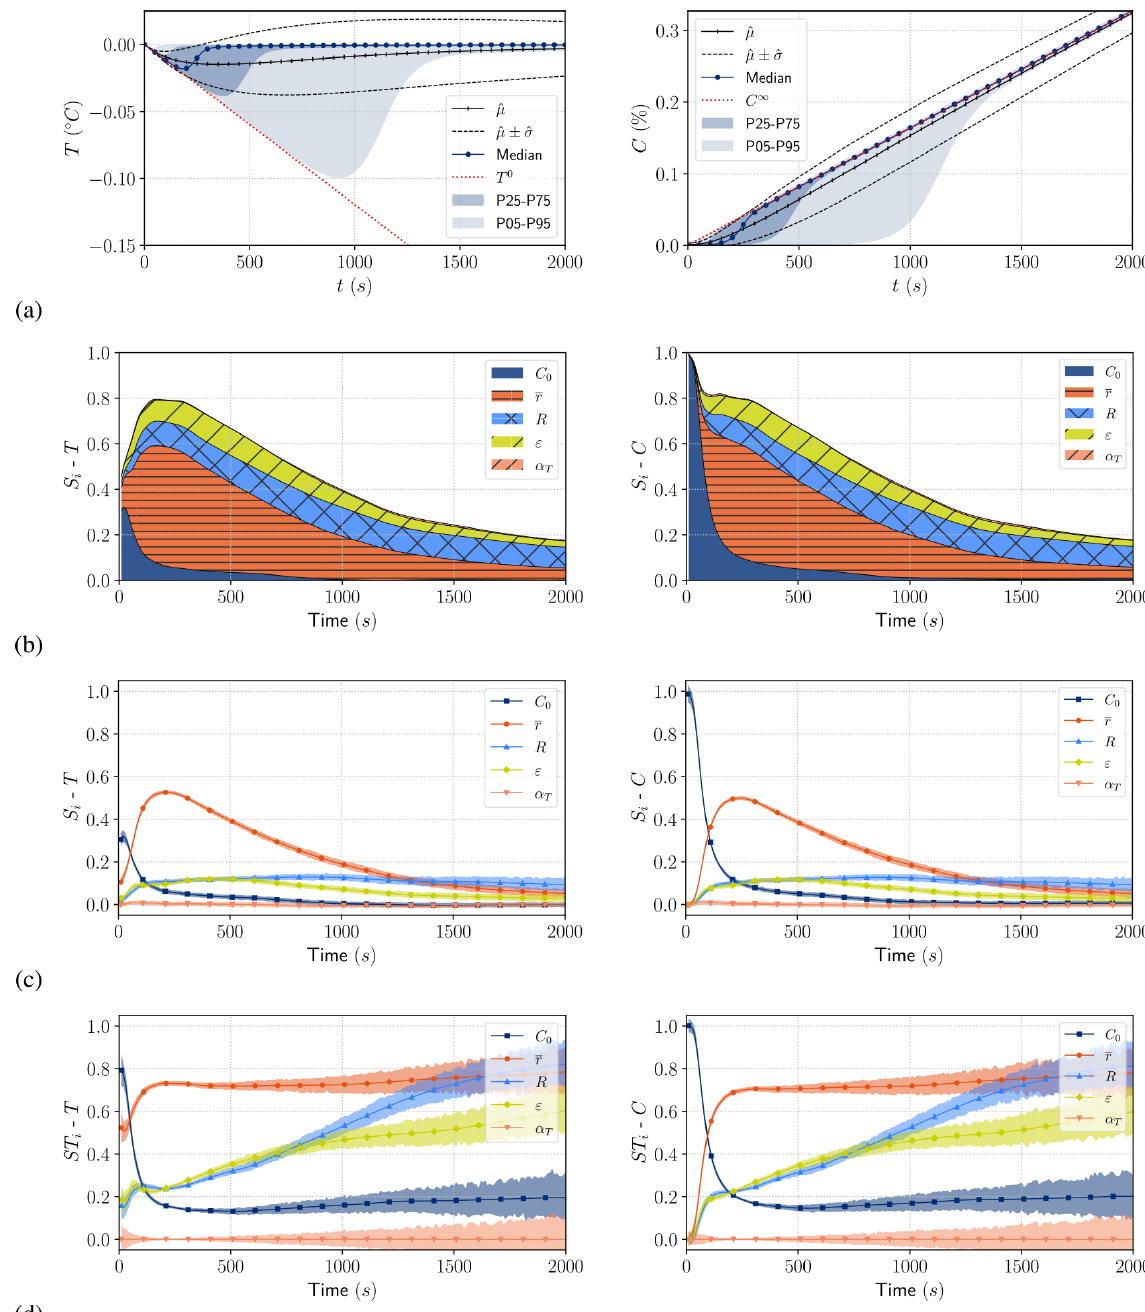
Figure F1. Results of case 1. From top to bottom: uncertainty propagation result (a) , first-order Sobol indices (b) , first-order Sobol indices with 95% confidence intervals (c) , and total-order Sobol indices with 95% confidence intervals (d) for temperature (left panels) and frazil (right